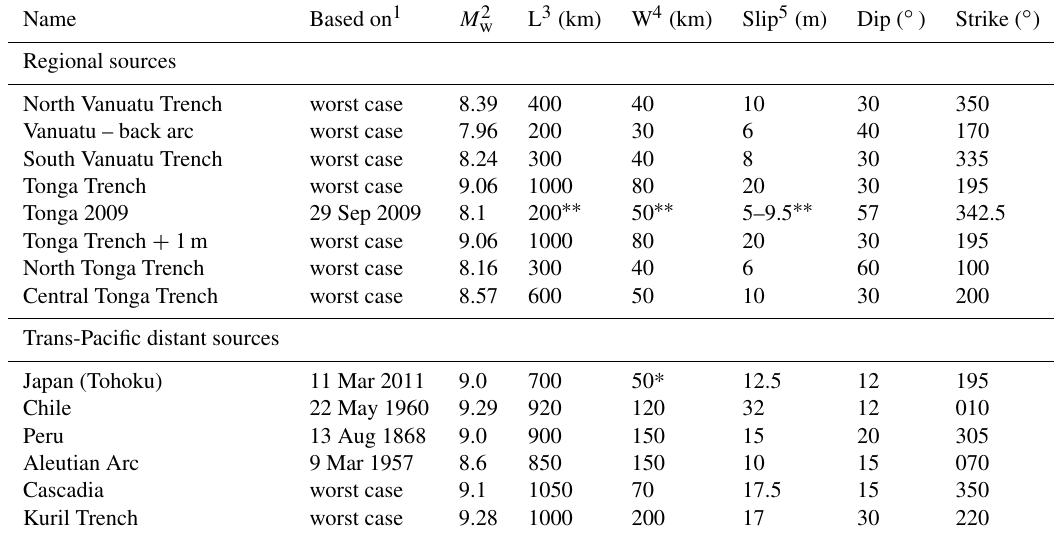
Table 2. Compilation of plausible worst-case earthquake scenarios based on a combination of the largest historical earthquakes and/or established earthquake fault models (after Lamarche et al., 2015). The rake angle is 90 ◦ for all